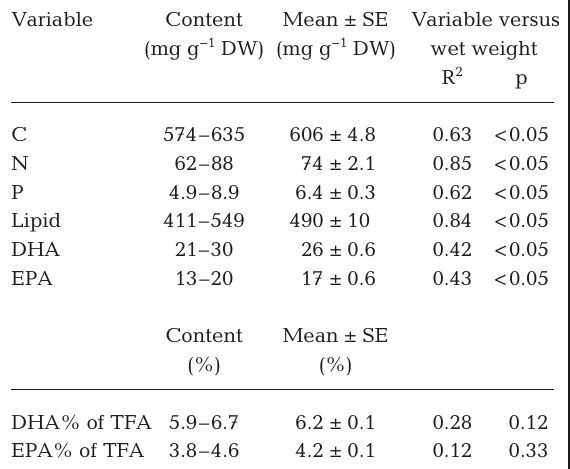
The dry matter content of faeces was in the range of 11 to 25% of wet weight with a mean of 15 ± 0.6% (n = 29). No differences were found in P content of faeces among different months for Cage S (ANOVA, p > 0.05; Fig. 7), while the other chemical compo- nents of faeces showed significant differences among